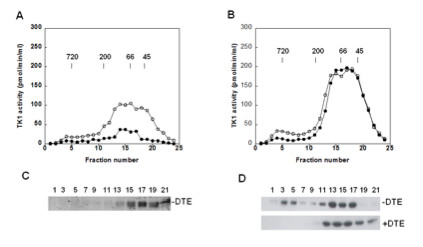
Size distribution of cytosolic TK1. TK1 activity in each fraction was measured using [3 H]-dThd as substrate. MDCK extracts (A) and CEM extracts (B) analyzed directly (○) or treated with DTE (●) prior to chromatography. Arrows indicate the elution position of the molecular weight markers. Western blot analyses of cytosolic canine TK1 (C) and human TK1 (D) in the FPLC fractions using polyclonal anti-dog TK1 antibody or mouse monoclonal anti-TK1 antibody for detection. Pre-treatment with DTE is indicated as + DTE. The numbers represent FPLC fractions.